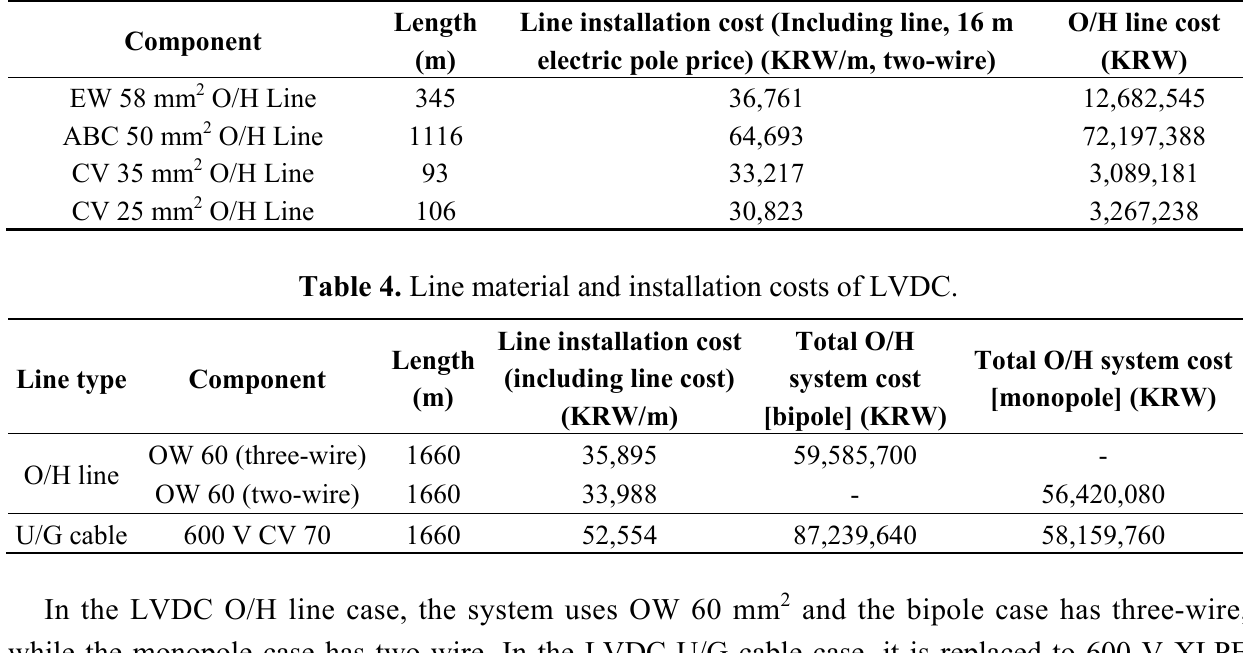
Table 3. Line material and installation costs of MVAC. EW: equipment wire; ABC: aerial bundled cable; and CV: XLPE insulated PVC sheathed cable.